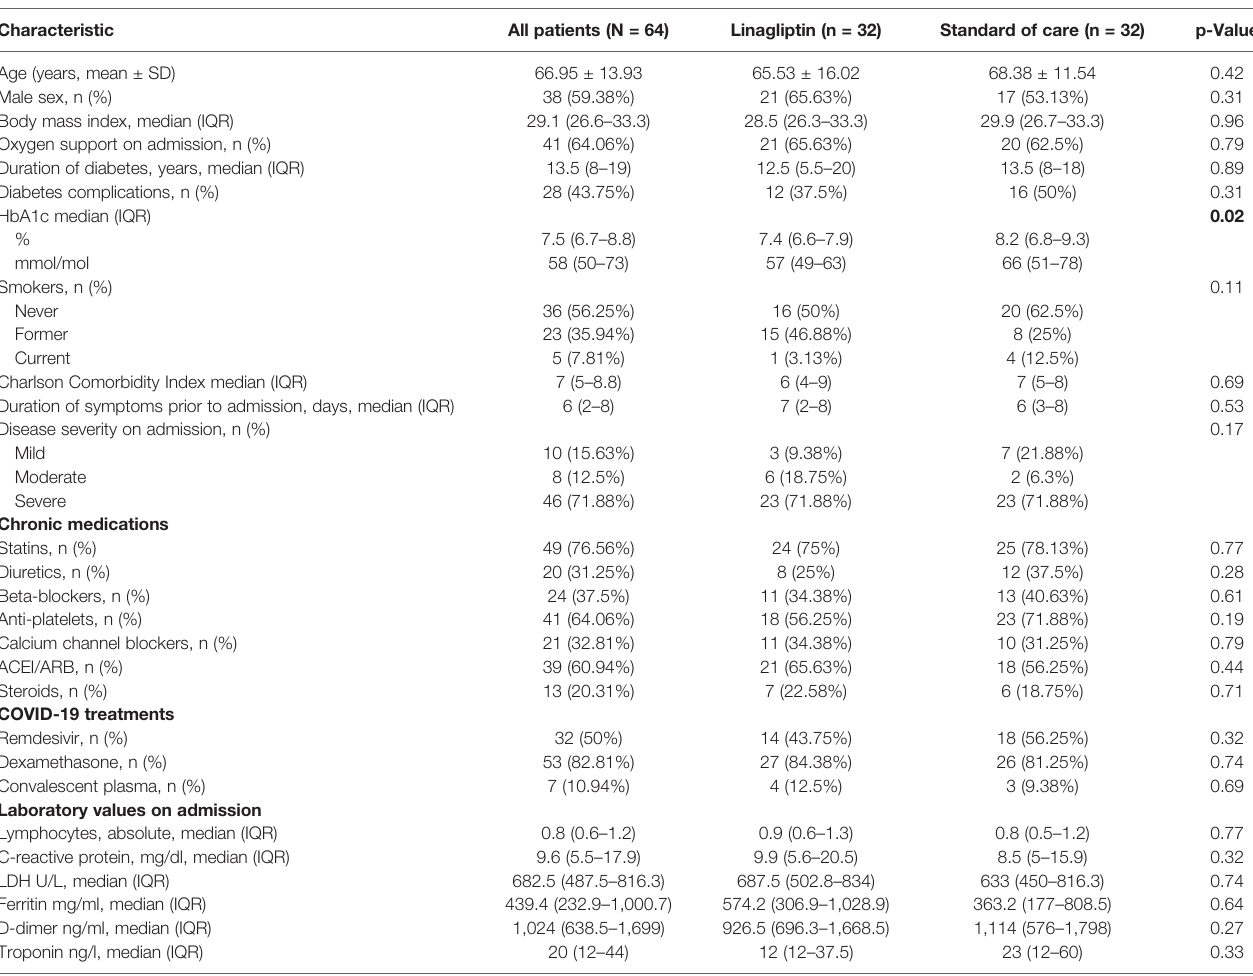
TABLE 1 | Characteristics of the patients at baseline.